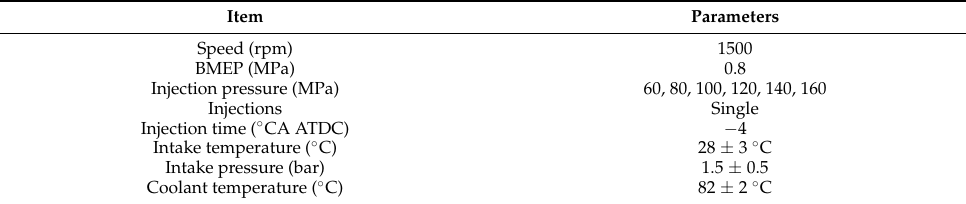
Table 2. Engine operating conditions.